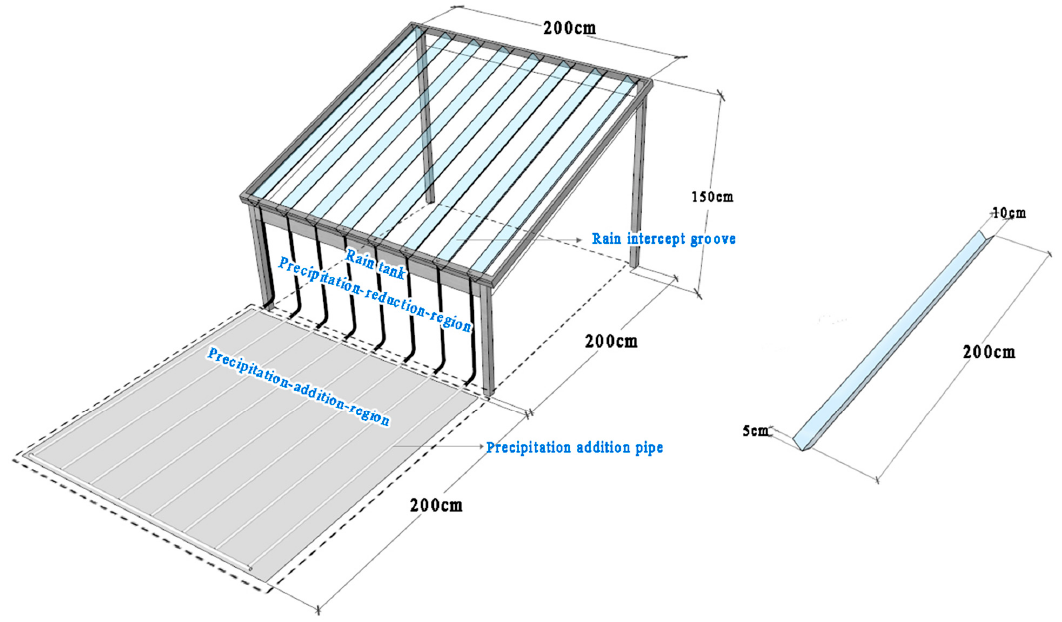
Figure 1. Precipitation addition-reduction apparatus.